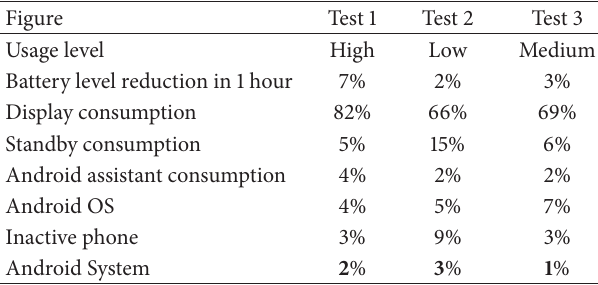
Table 4: Estimated percent of power consumption due to NFC tag reading operations. Figure